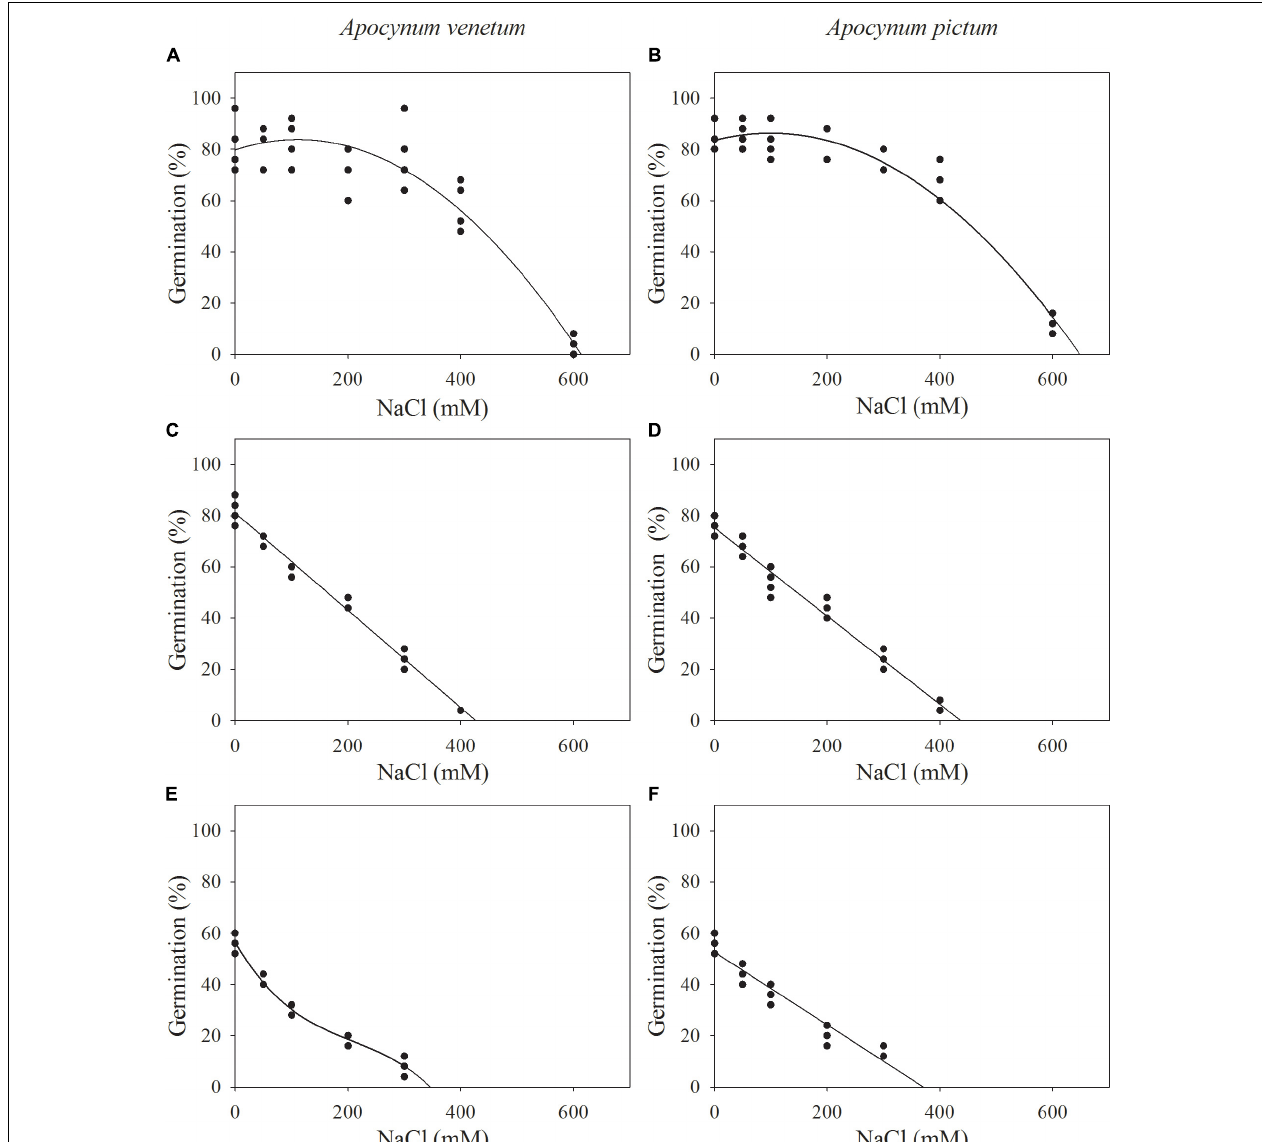
FIGURE 6 | Relationship between germination percentages of Apocynum venetum and Apocynum pictum seeds stored for 0 year (A,B) , 1 year (C,D) , and 2 years (E,F) and NaCl